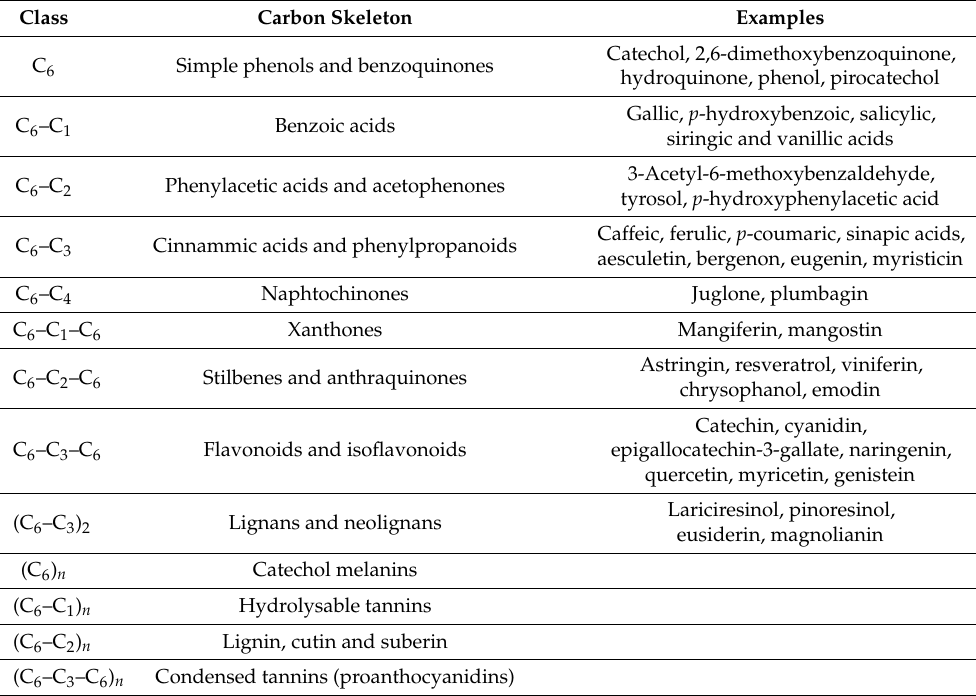
Table 1. The main classes of phenolic compounds according to their carbon